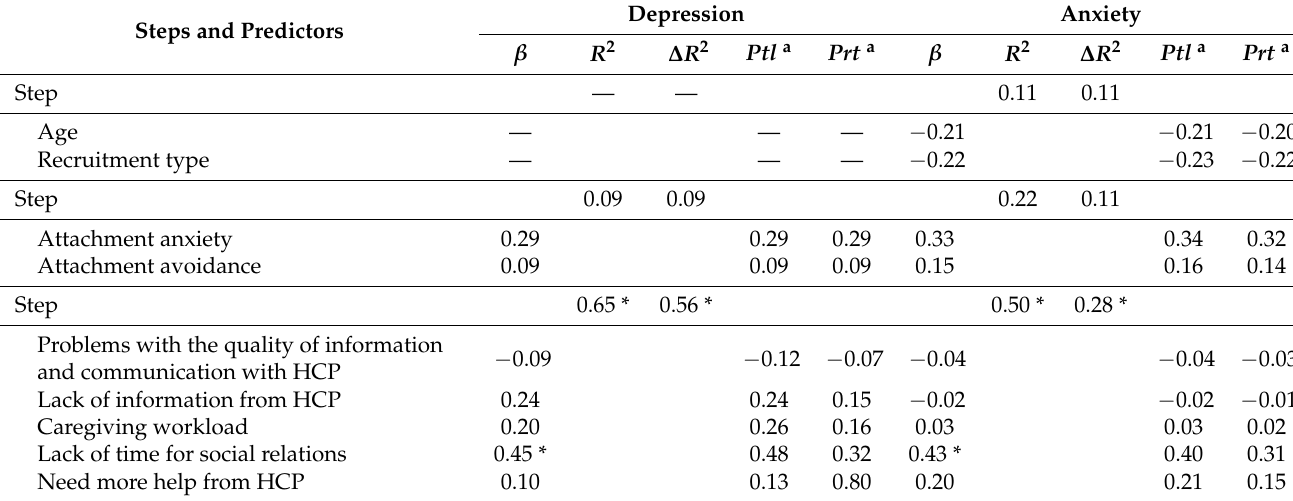
Table 2. Hierarchical regression models for attachment insecurity, and caregiving experiences in cancer care as predictors of symptoms of depression and